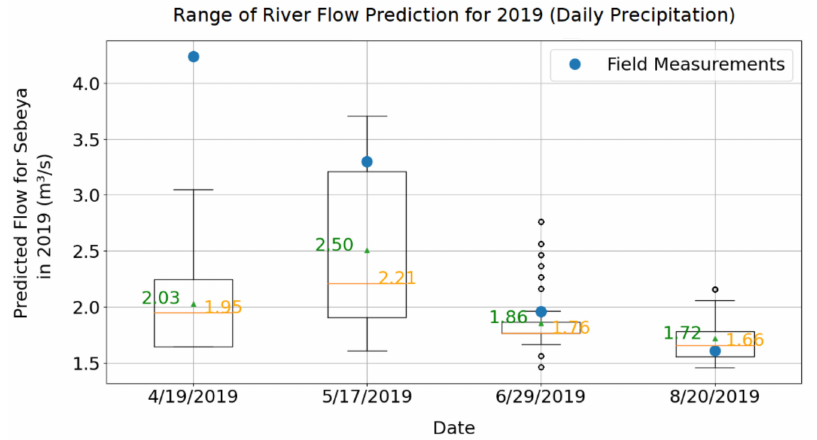
Figure 5. Predicted and measured river flow rate. Boxplots represent the inner and outer quartiles and outliers. Blue points are measured river flow